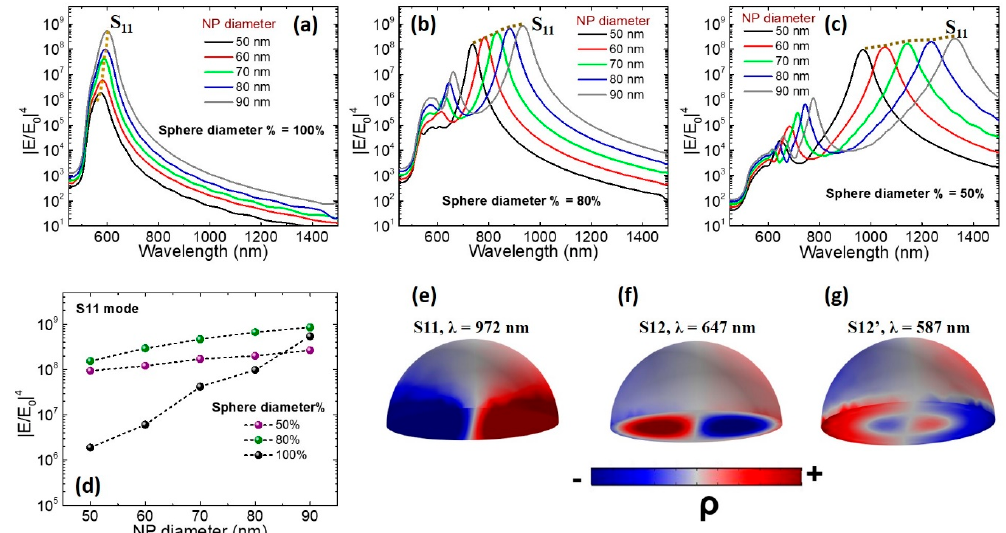
Figure 4. ( a – c ) Broadband | E / E 0 | 4 spectrum for different NP diameters ranging from 50 to 90 nm as function of 100%, 80%, or 50% sphere diameter percentage in NPOM plasmonic structure. ( d ) Extracted maximum near field enhancement for S 11 mode for different sphere D % from figures ( a – c ). 3D surface charge distributions for S 11 , S 12 , and S 12 ′ modes taken from hemispherical NPs with D = 50 nm ( e – g ).